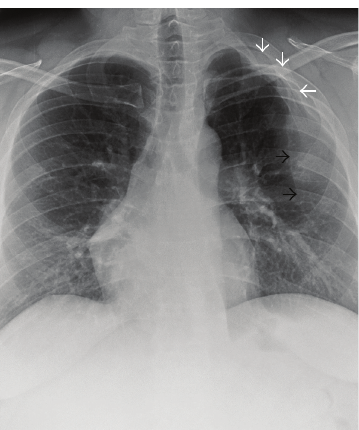
Figure 1: 43-year-old gentleman complaining of high grade fever, cough, and chest pain was investigated with chest radiographs and helical chest CT scan and subsequently diagnosed with intrathoracic ribs. Chest radiograph shows left upper and mid-zone opacity (black arrows) and depression of bifid left third rib (white arrows). Upper lobe of the left lung is hypoplastic.